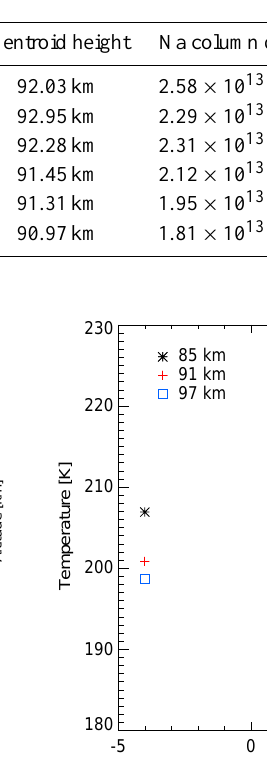
Fig. 5. As Fig. 3, but 19 December 2010. The vertical line indicates the launch of ECOMA 9. The data gap from 08:48 to 13:13 UT is due to daylight conditions.